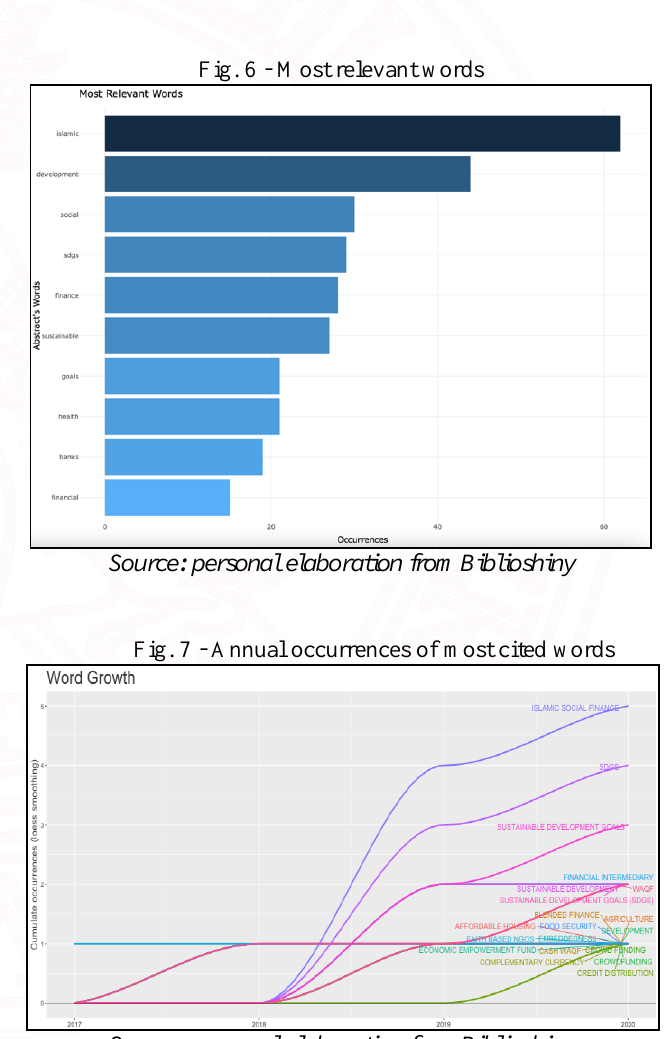
Source: personal elaboration from